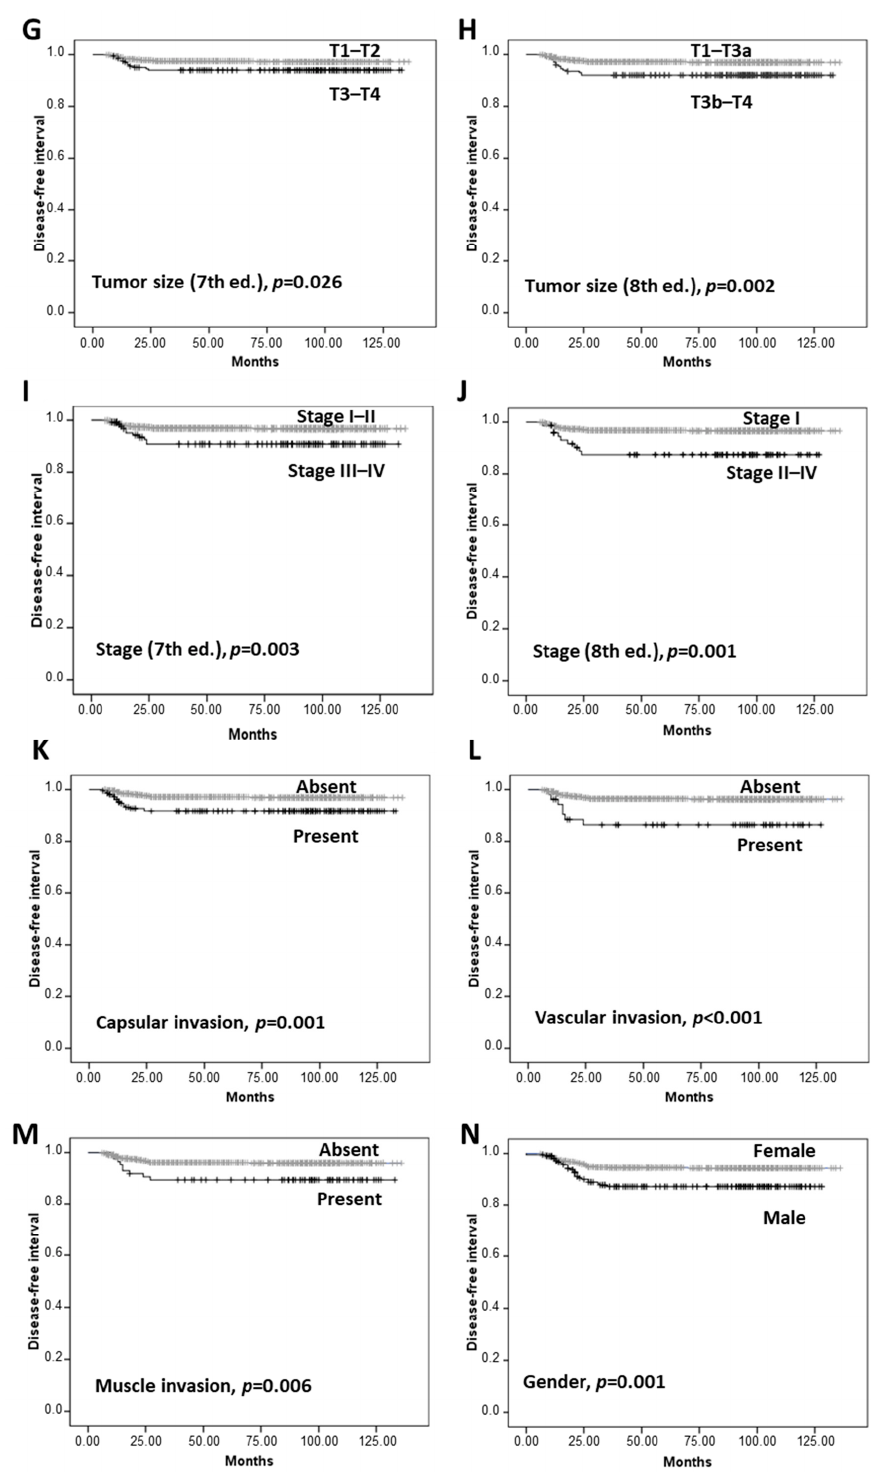
Figure 2. Kaplan–Meier analysis. Kaplan–Meier curves with Mantel–Cox log-rank statistical text were made to estimate the impact on disease-free interval (DFI) at age < 55 years or ≥ 55 year ( A ), age < 45 years or ≥ 45 years ( B ), PTC histological variants ( C ), AITD ( D ), multifocality ( E ), lymph node metastases ( F ), tumor size (7th edition) ( G ), tumor size (8th edition) ( H ), stage (7th edition) ( I ), stage (8th edition) ( J ), capsular invasion ( K ), vascular invasion ( L ), muscle invasion ( M ), or gender ( N ). p values < 0.05 are evidenced in